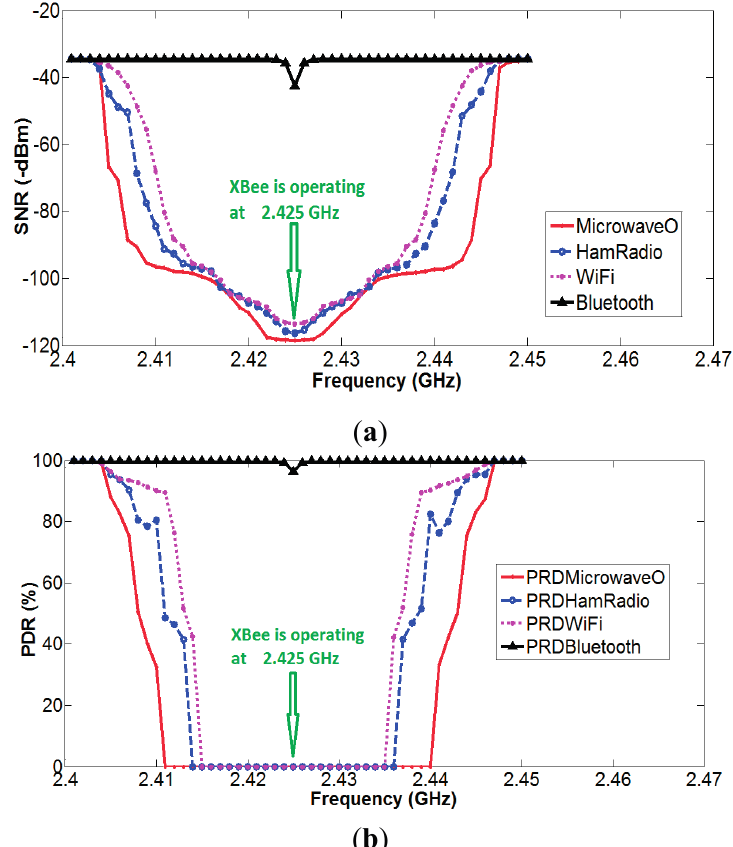
Figure 19. ( a ) SNR vs. operating frequency of different RF sources in ISM band; and ( b ) PDR vs. operating frequency of different RF sources in ISM band to investigate effect of interferences on ZigBee smart building